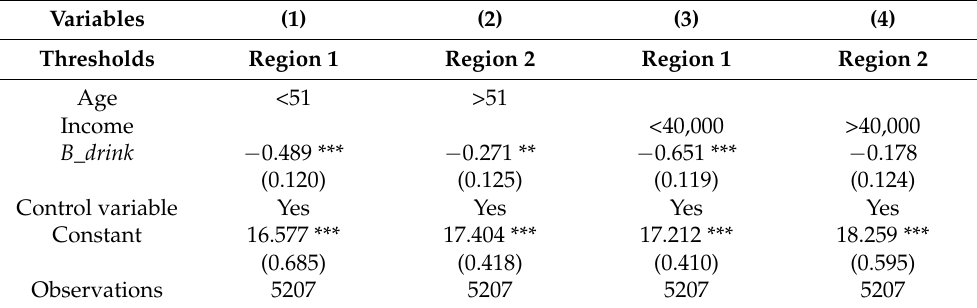
Table 6. Regression of thresholds for age and family